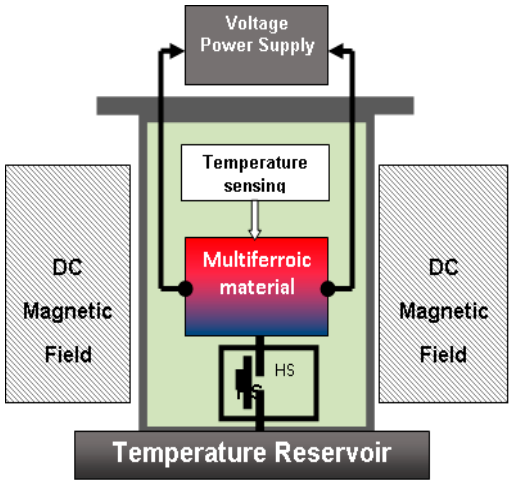
Figure 6. Schematic of the multicaloric testing system. HS = heat switch; ∆ T is measured under adiabatic demagnetization and depolarization. The multiferroic material is kept adiabatically under vacuum. The HS can connect/disconnect the material to/from the temperature reservoir, providing the operating T . The temperature change is measured using non-contact IR thermometry or low heat capacity temperature sensors. Image modified from [83].